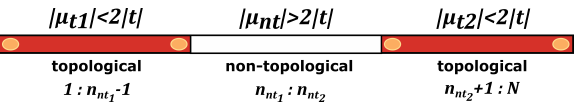
Figure 3: A Kitaev chain nanowire separated into three segments - two topological segments (red) and a non-topological segment (white) in between. The total number of sites is N and the non topological segment ranges between sites n are four MZM’s (yellow circles) on this wire - two pairs localized at the edges of the two topological